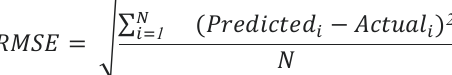
Fig. 2. Data Visualization of closing price of Dogecoin